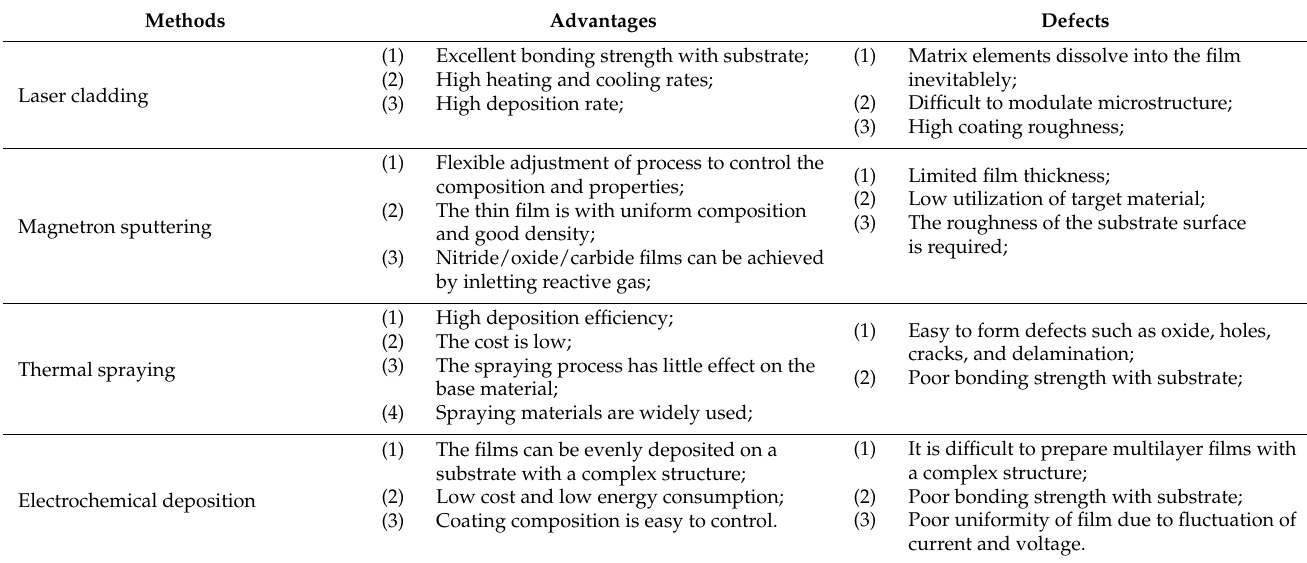
Table 1. Technology characteristics of laser cladding, magnetron sputtering, thermal spraying, and electrochemical deposition